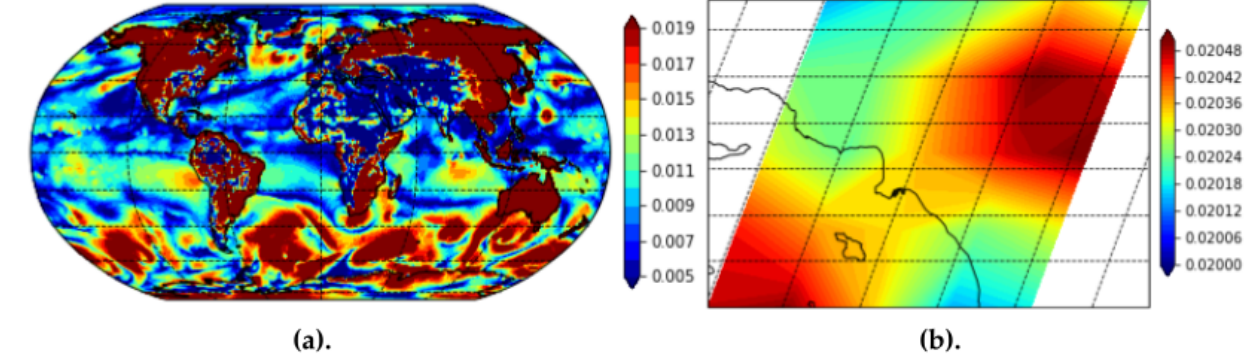
Figure 10. MERRA-2 Surface Exchange Coefficient for Heat visualization over various geographic scales, ( a ) Global, ( b ) Los